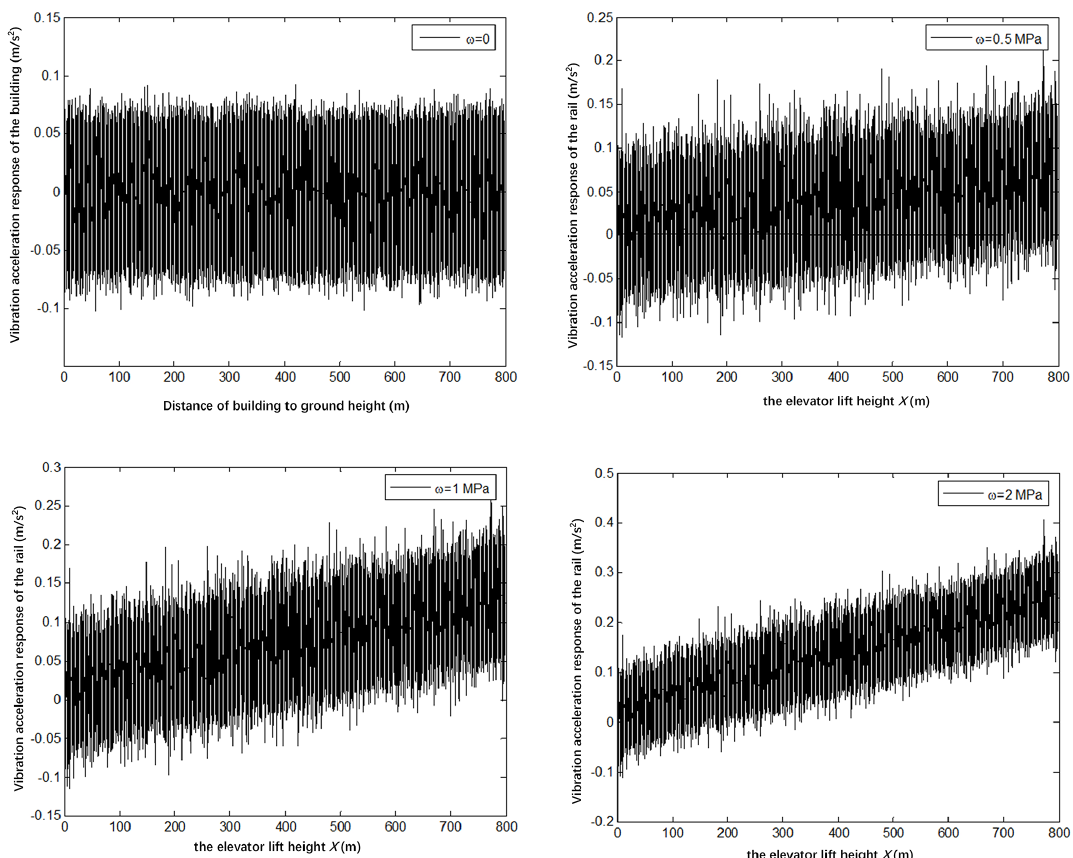
Figure 4. Vibration acceleration curve of the guide rail under different basic wind pressure